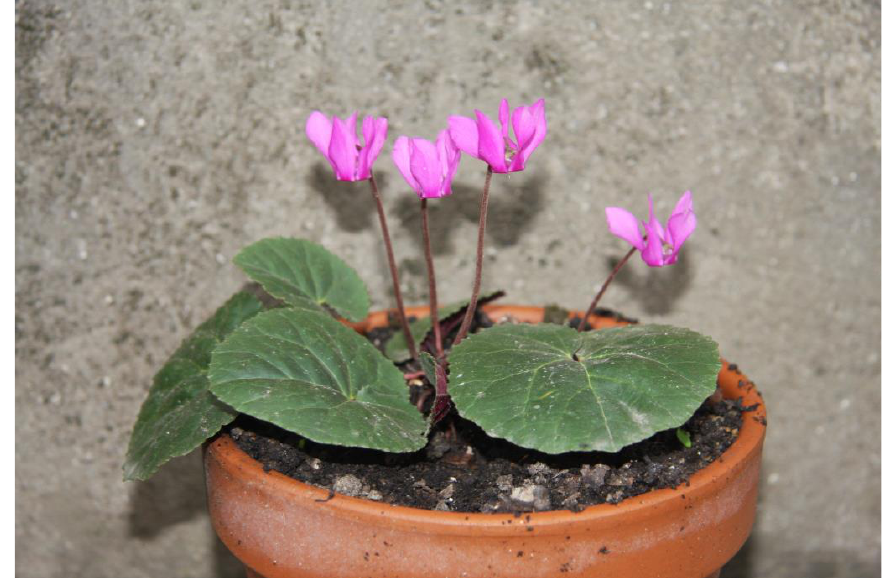
Figure 15. C. purpurascens ‘Cankar’.